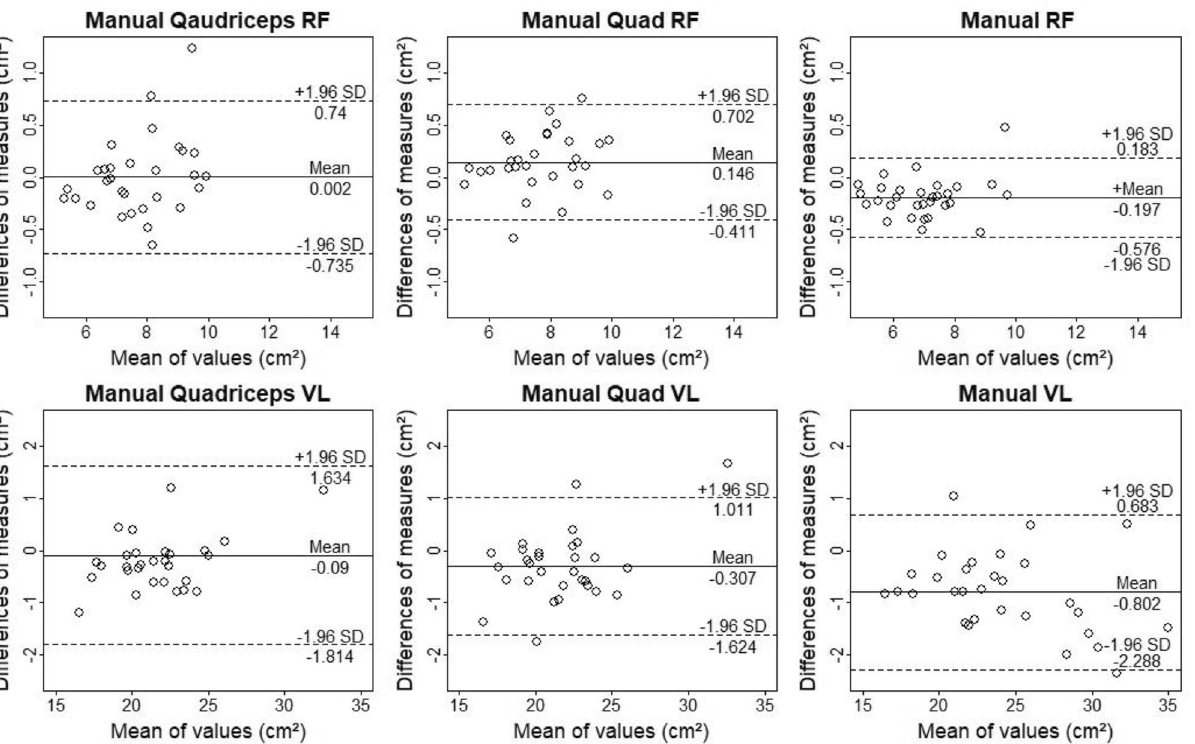
Figure 4. Bland–Altman plots of all modes using “Manual” outline-finder option comparing two measurements of investigator1. M. rectus femoris (RF) and m. vastus lateralis (VL). The differences between measurements are plotted against measurement means. Dotted and solid lines illustrate 95% limits of agreement and bias. During the “Quadriceps” modalities both muscles are analysed in one image. During the “Quad” modalities, only one muscle is evaluated per image even though both muscles are displayed. During RF and VL modalities, both muscles were analysed in separate